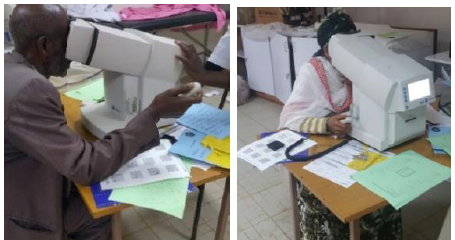
Figure 9. Patients with the response button during a visual field test with